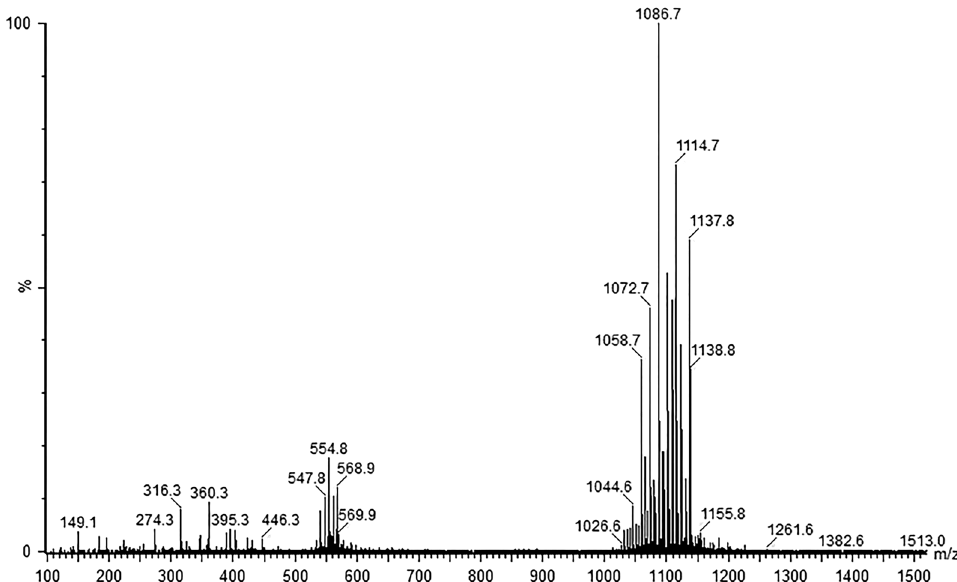
Figure 3. Mass spectrometry analysis of biosurfactant produced by strain SL.